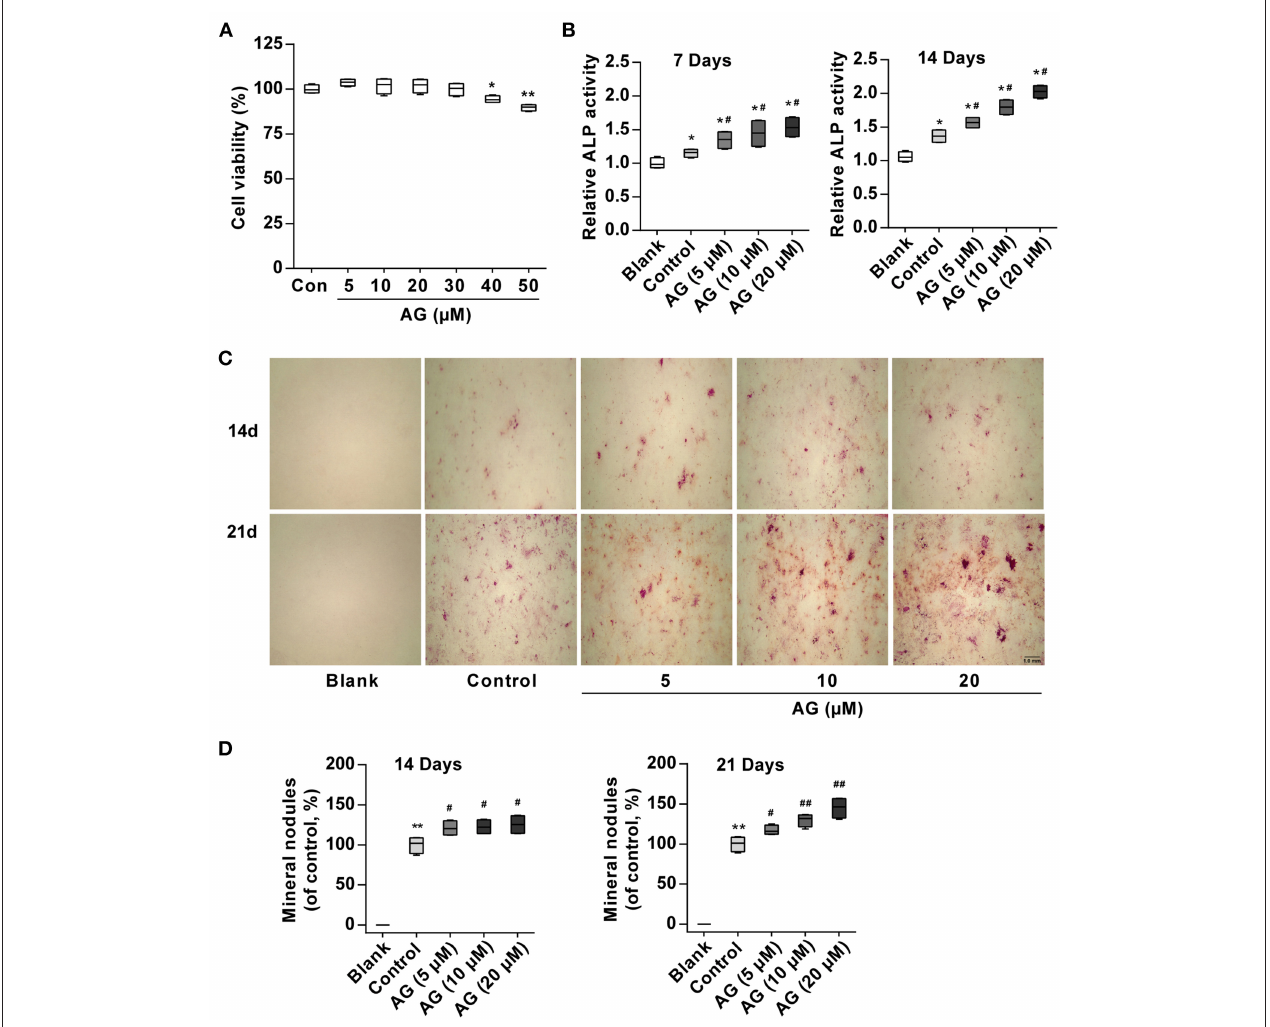
FIGURE 1 | The effects of AG on osteoblastic differentiation and matrix mineralization in mouse MC3T3-E1 cells. (A) Viability of MC3T3-E1 cells was measured by MTT assay after 48h of AG treatment. * P < 0.05, ** P < 0.01 compared with the control group. N = 4. (B) ALP activity was determined by using the Alkaline Phosphatase Assay Kit after 7 and 14 days of AG treatment. * P < 0.05 compared with the corresponding blank group. # P < 0.05 compared with the corresponding control group. N = 4. (C) Representative images of mineralized nodules after Alizarin Red S staining. Scale bar, 1.0mm. (D) Quantitative analysis of mineralized nodules after Alizarin Red S staining. * P < 0.05 compared with the corresponding blank group. # P < 0.05, ## P < 0.01 compared with the corresponding control group. N = 4. All of the data are shown as the mean ± S.D. of the independent